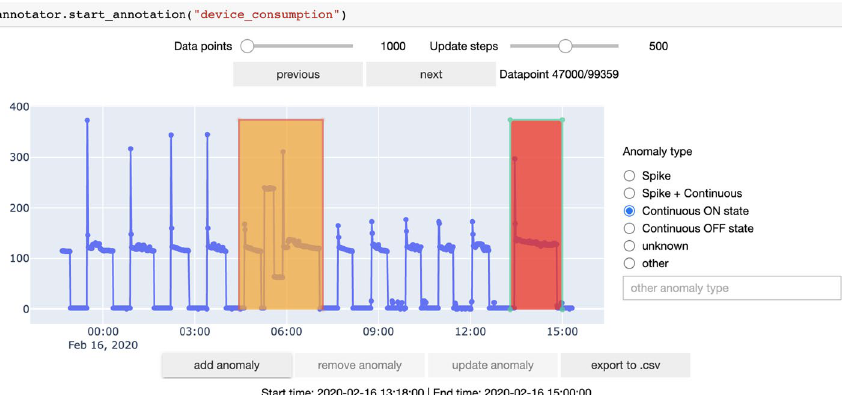
Fig. 3 The interface of the GT anomaly annotator at work on the fridge time series. The user can specify the anomalies and add meta-data to them. The user has annotated the currently selected GT anomaly, shown in red, with the Continuous ON state